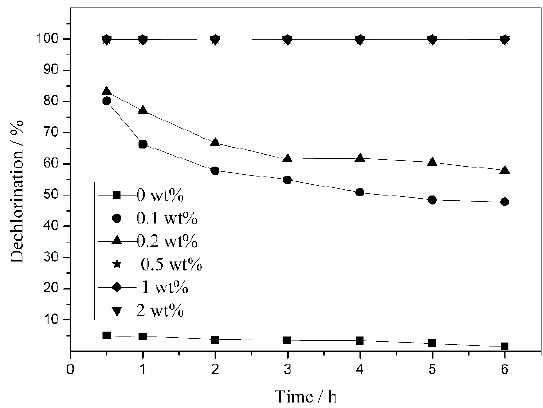
Figure 4. Dechlorination of 4-CP during an HDC reaction in a Pd/CNT-Ni foam micro reactor with different Pd loadings. Reaction conditions: residence time (3 min), FA/substrate molar ratio (5:1), 4-chlorophenol concentration (1 mmol/L).